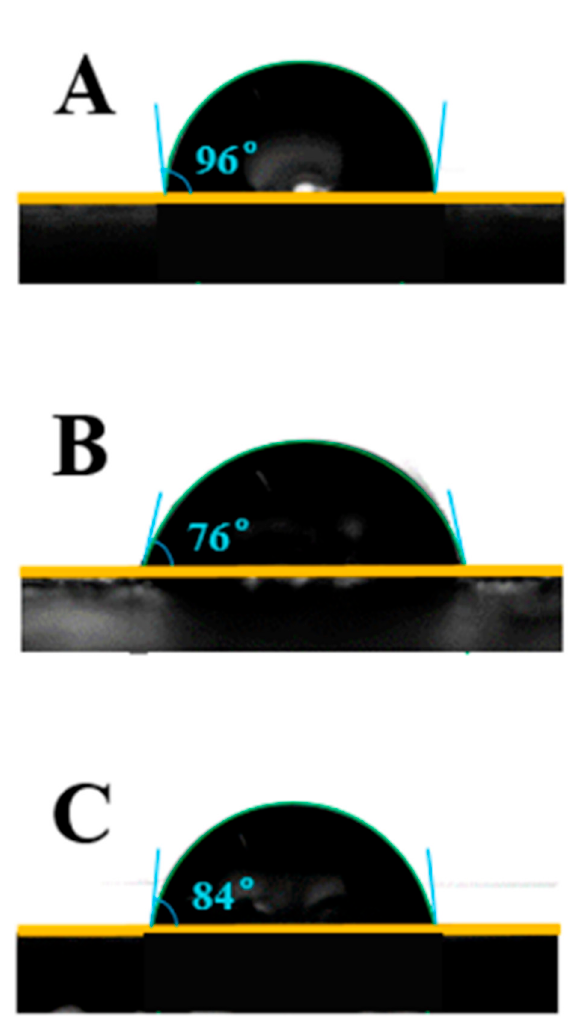
Figure 6. Images of water contact angle of coating materials: ( A ) FPU; ( B ) CPU; and ( C ) FCPU.